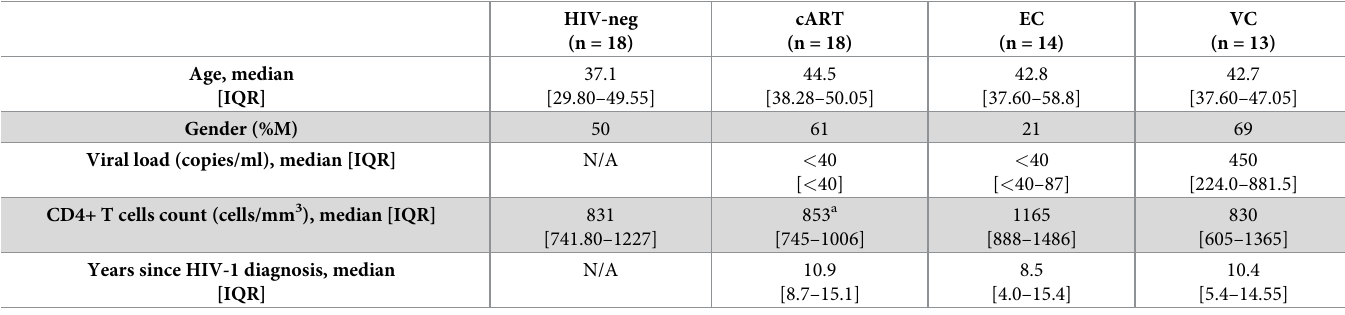
Table 1. Demographic and clinical characteristics of study